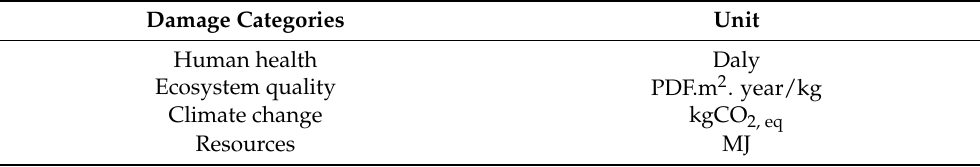
Table 5. Characteristics of damage